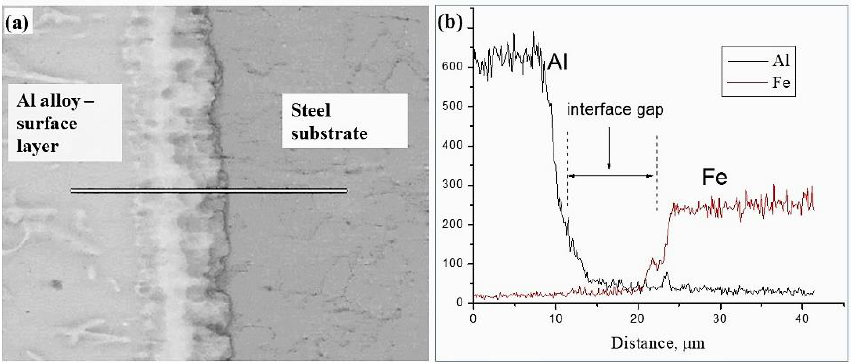
Figure 8. ( a ) SEM image of the cross-section of steel — Al alloy coating interface for steel with flux pre-treatment surface and dipping time of 30 s; ( b ) line scan results across the interface.